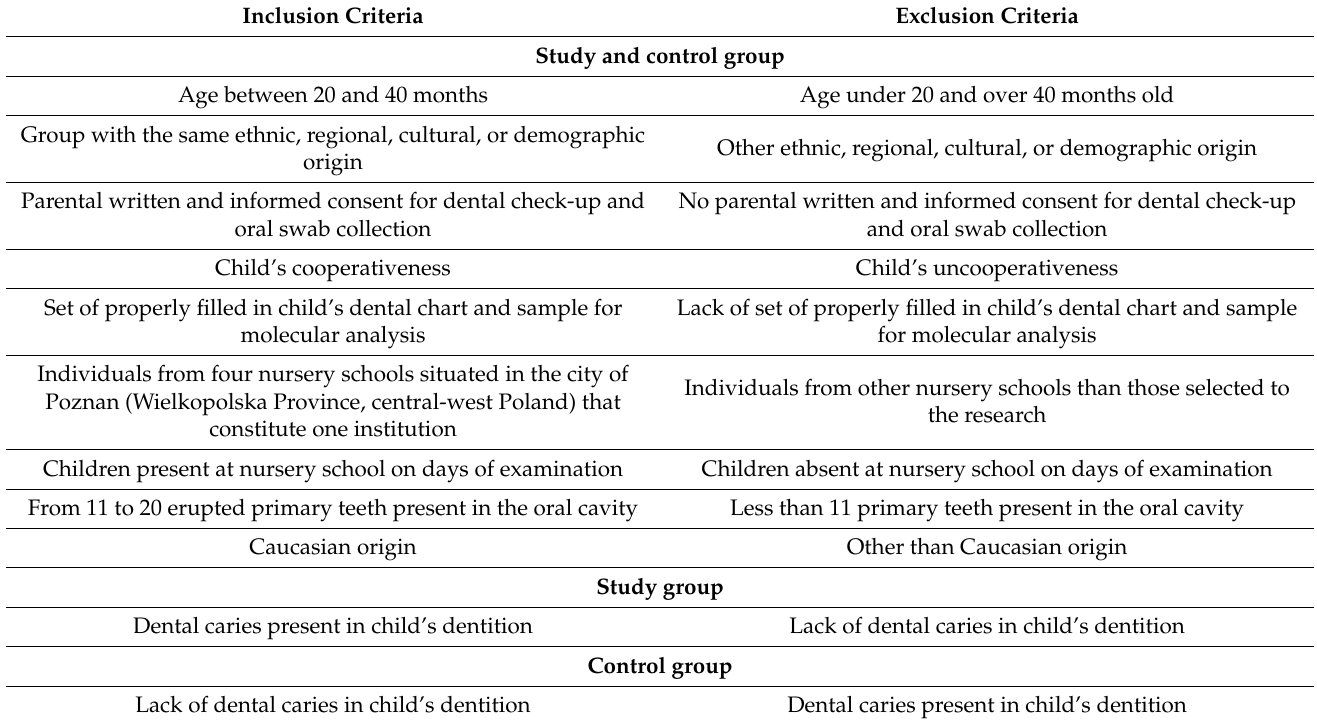
Table 2. Inclusion and exclusion